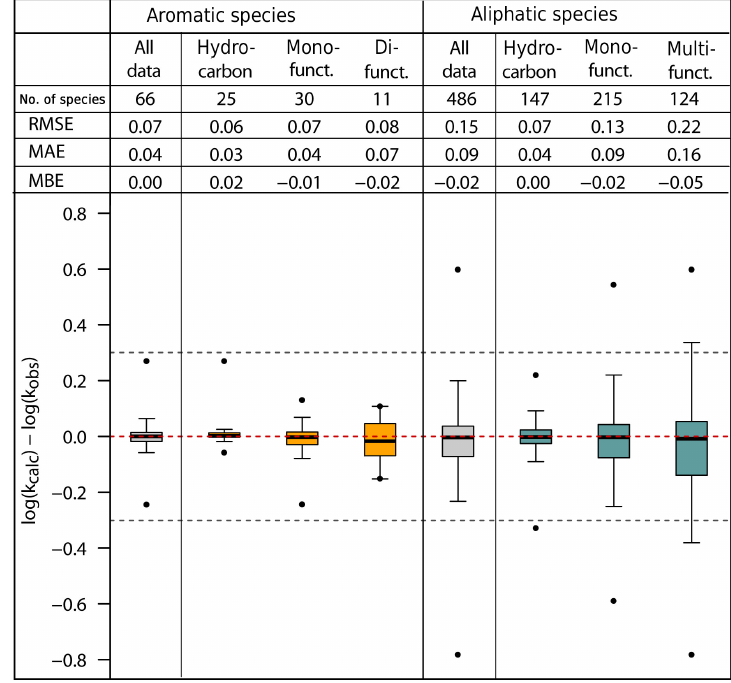
Figure 7. Root mean square error (RMSE), mean absolute error (MAE), mean bias error (MBE) and box plot for the error distribution in the estimated log k 298K values for the full set and subsets of the aromatic species in the database, and for the aliphatic species reported previously (Jenkin et al., 2018a). The bottom and the top of the boxes are the 25th ( Q 1 ) and 75th percentiles ( Q 3 ), the black band is the median value. The whiskers extend to the most extreme data points which is no more than 1.5 × ( Q 3 – Q 1 ) from the box. The points are the extrema of the distribution. The black dotted lines correspond to agreement within a factor